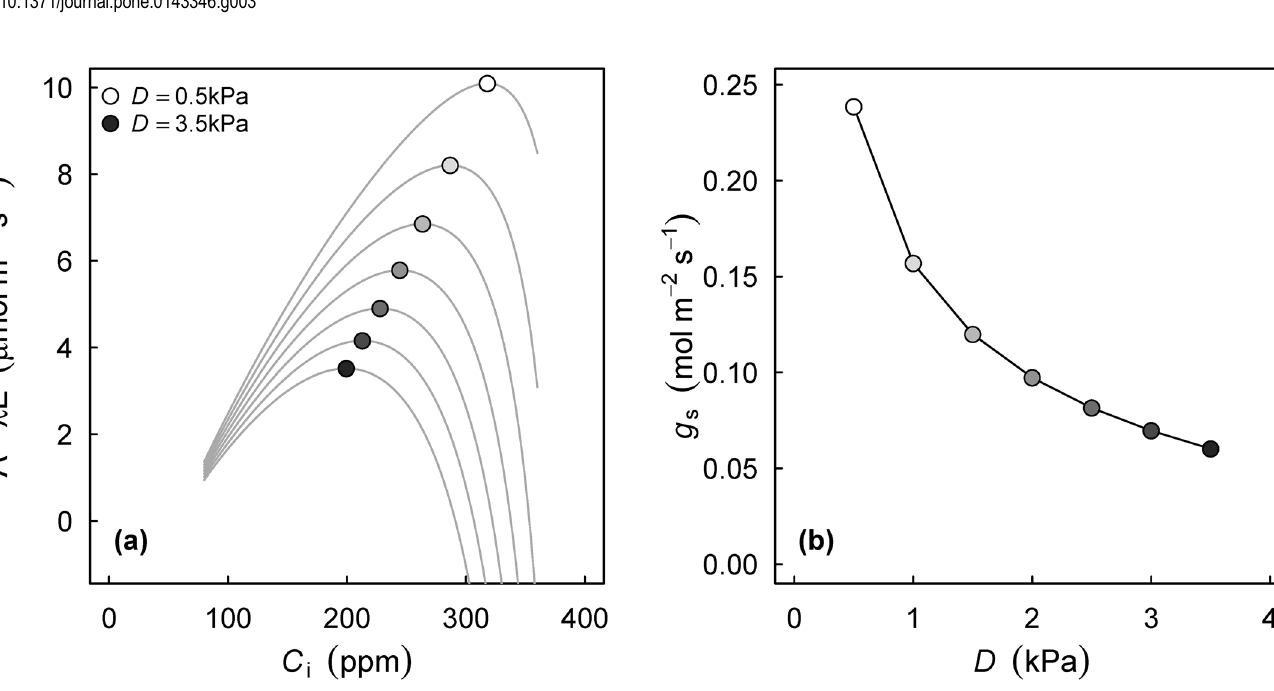
PLOS ONE | DOI:10.1371/journal.pone.0143346 November 18,